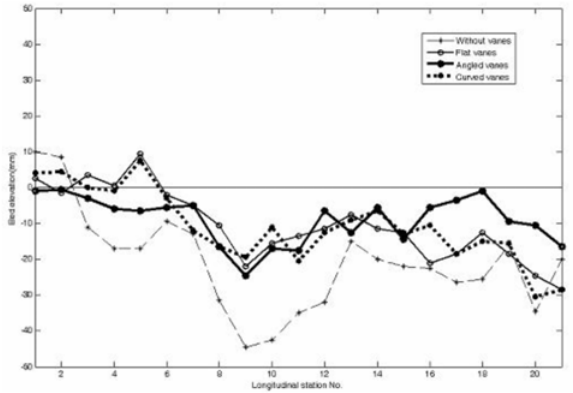
Fig. 16. Longitudinal bed profiles 3-cm from outer bank in zigzag pattern on